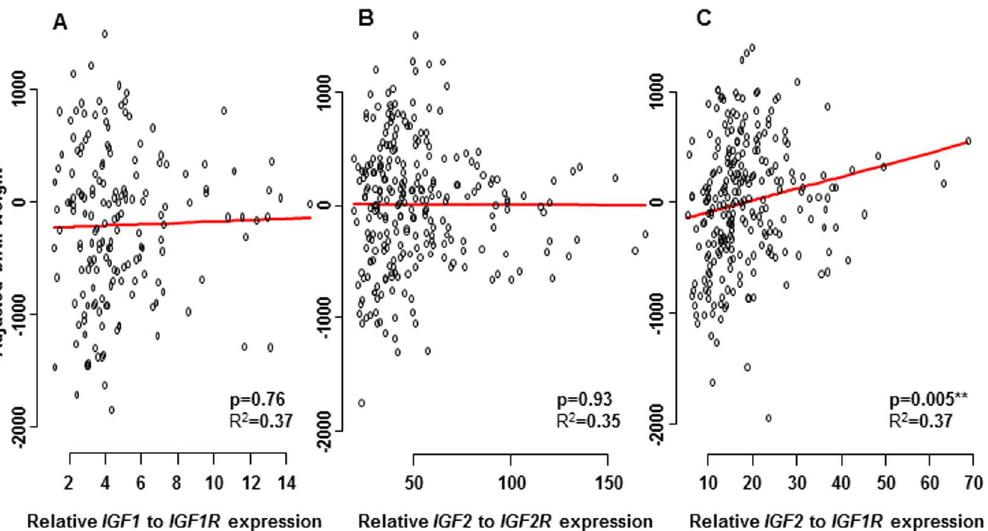
Figure 2. mRNA expression levels of IGF1/IGF1R , IGF2 / IGF2R and IGF2/IGF1R in chorionic villi. The expression levels of IGF1/IGF1R , IGF2/ IGF2R and IGF2/IGF1R after standardization to the endogenous control gene L19 , in relation to birth weight corrected for parity, sex, GA at term, maternal BMI and smoking status. No significant association was found for A) the ratio of IGF1 to IGF1R (p=0.76), or for B) the ratio of IGF2 to IGF2R (p=0.93). Significant association was observed for CVS expression of C) the ratio of IGF2 to IGF1R (p=0.005) and birth